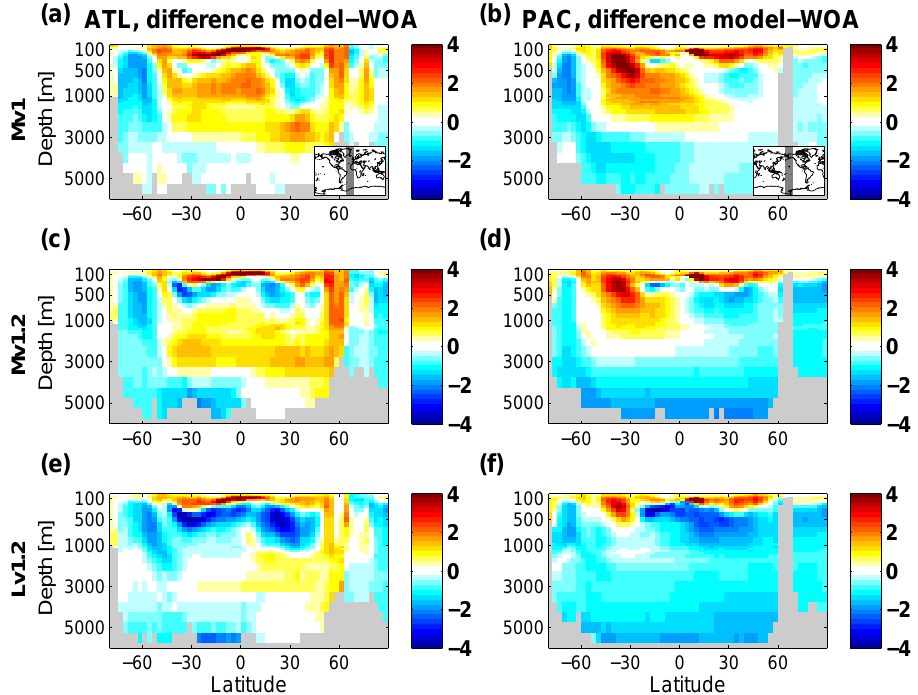
Figure 1. Temperature difference model − WOA averaged over 1965–2007 along zonal mean sections through the Atlantic/Southern Ocean (a, c, e) and the Pacific/Southern Ocean (b, d, f) for model configurations Mv1 (a, b) , Mv1.2 (c, d) , and Lv1.2 (e, f) . The regions covered by the zonal mean calculations are indicated by the grey shaded area in the insets of panels (a) and (b) .